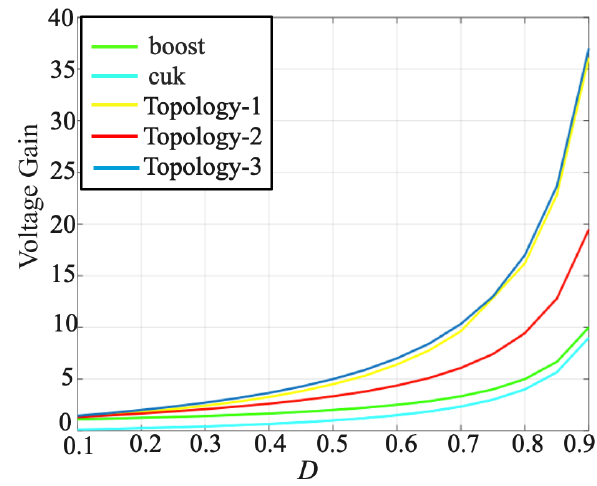
Figure 13. Comparison of converters in terms of voltage gain.